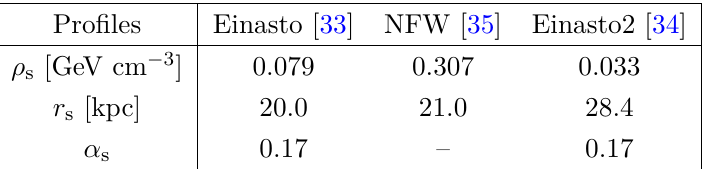
Table 2 . The cuspy DM density profiles used in ref.